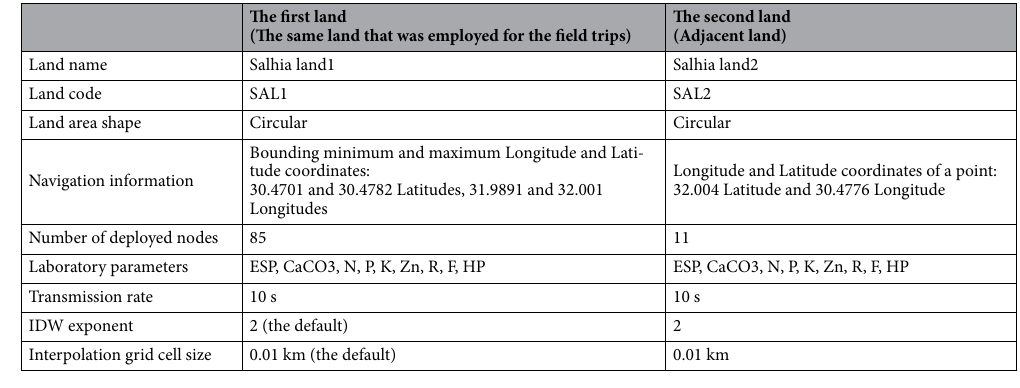
Table 4. Parameters of the validation scenario.